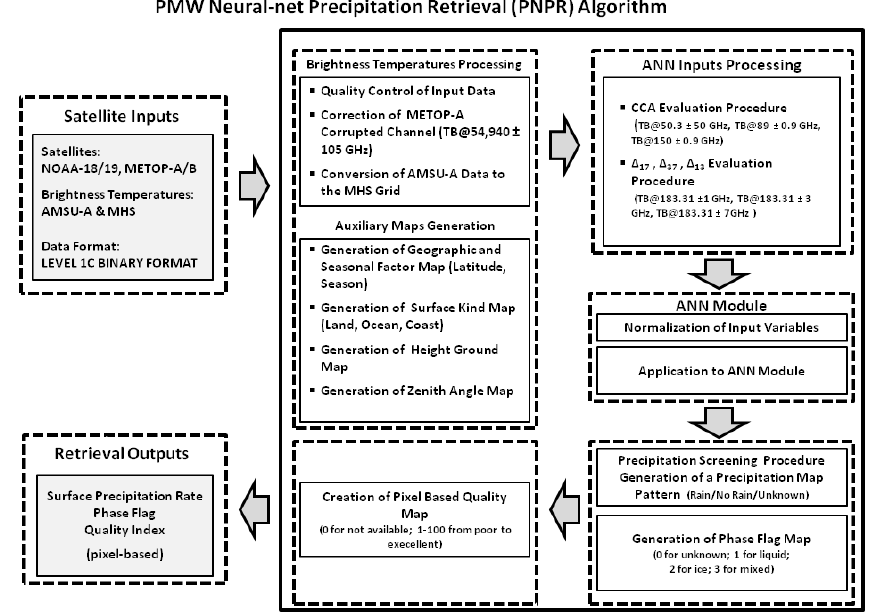
Figure 3. Flow diagram of the PNPR